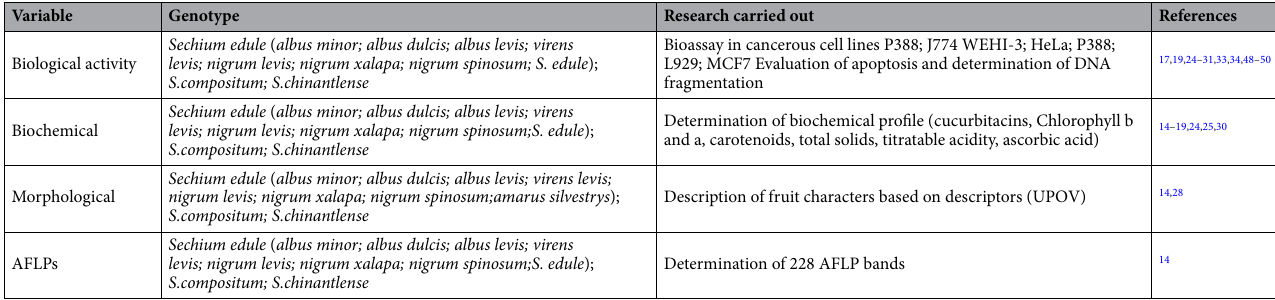
Table 6. Publications included for the bioprospecting meta-analysis in Sechium spp. UPOV International union for the protection of new varieties of plants, AFLP Amplified fragment length